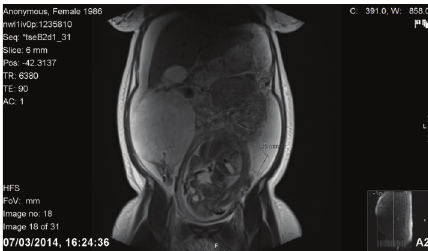
Figure 2: Coronal T2-weighted MR image revealing a gravid uterus with well-defined bilateral ovarian masses and extensive free fluid in the abdomen and pelvis.